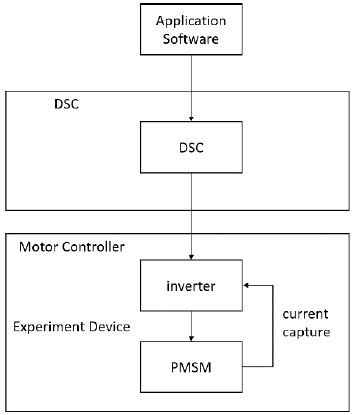
Figure 8. Hardware architecture.